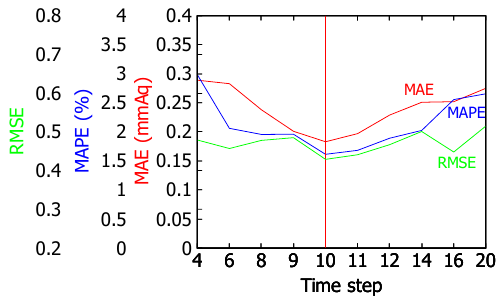
Figure 12. Prediction performance by time step.